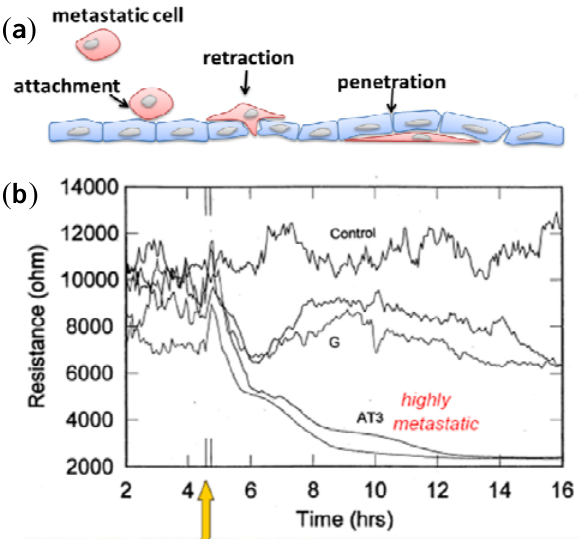
Figure 17. ( a ) Metastatic cells that invade the confluent HUVEC layer and cause damage to the barrier integrity; ( b ) HUVEC layer challenged with the weakly metastatic G subline or the highly metastatic AT3 subline. The loss of resistance was due to the loss of integrity of the endothelial cell layer in response to the activities of the cancer